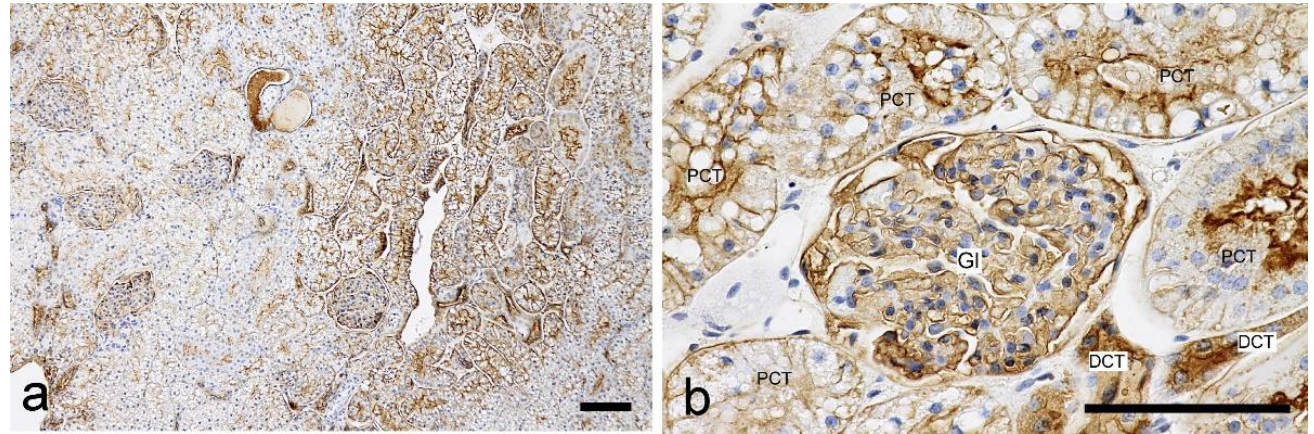
Figure 2. Histochemical staining for wheat germ agglutin (WGA) in the feline kidney. ( a ) Low magnification view of the cortex. Staining intensity is different between areas within the cortex. ( b ) High magnification view of the cortex with positive staining. Gl: glomerulus. PCT: proximal convoluted tubule. DCT: distal convoluted tubule. Scale bars: 100 μm.